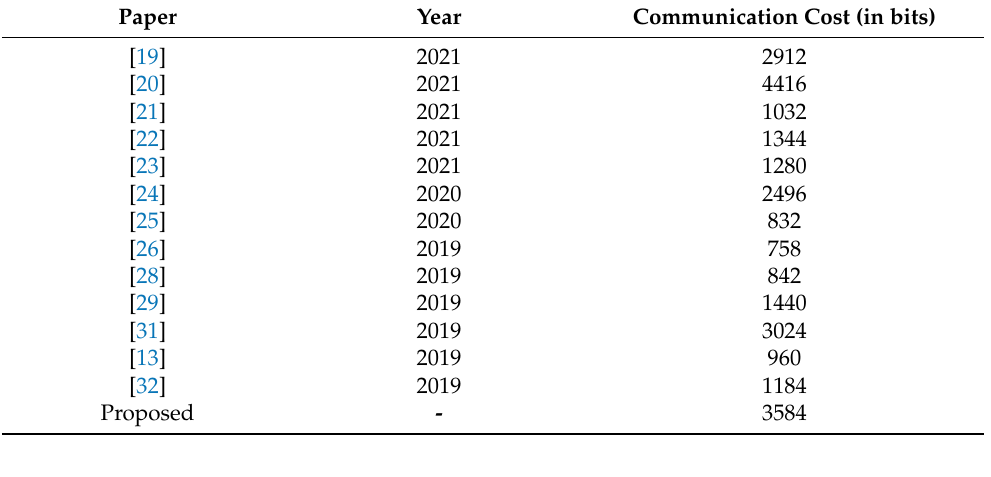
Table 9. Comparison of Transaction Overhead.